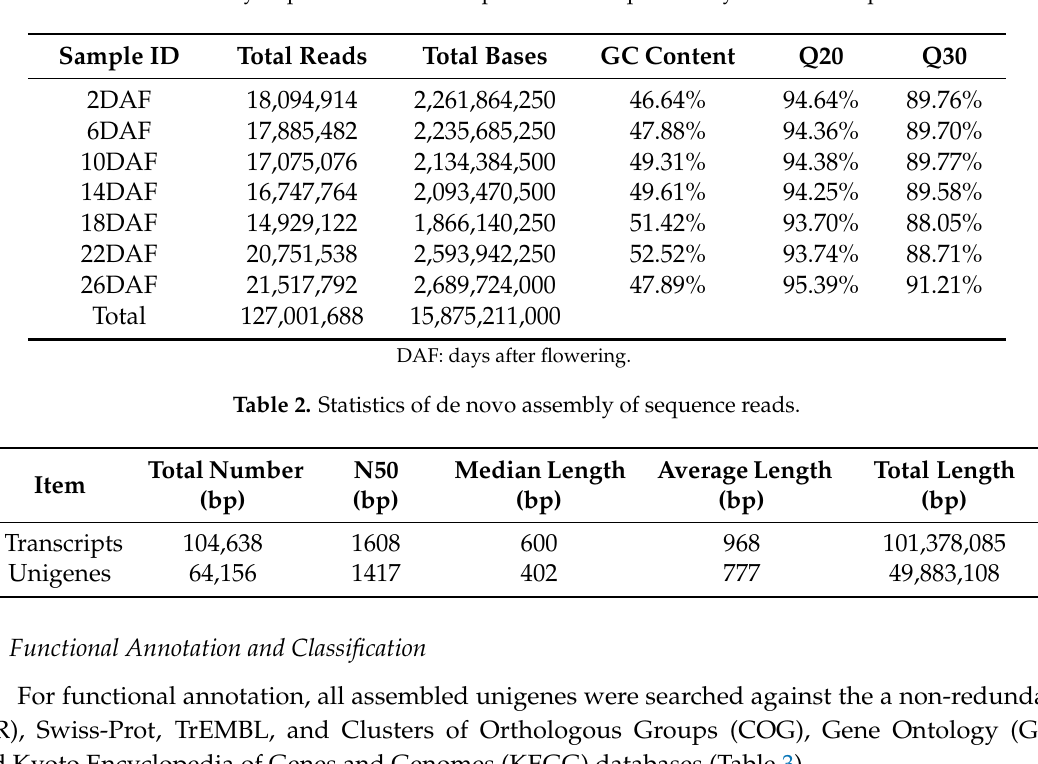
Table 1. Summary of perilla seed transcriptome data sequenced by the Illumina platform.